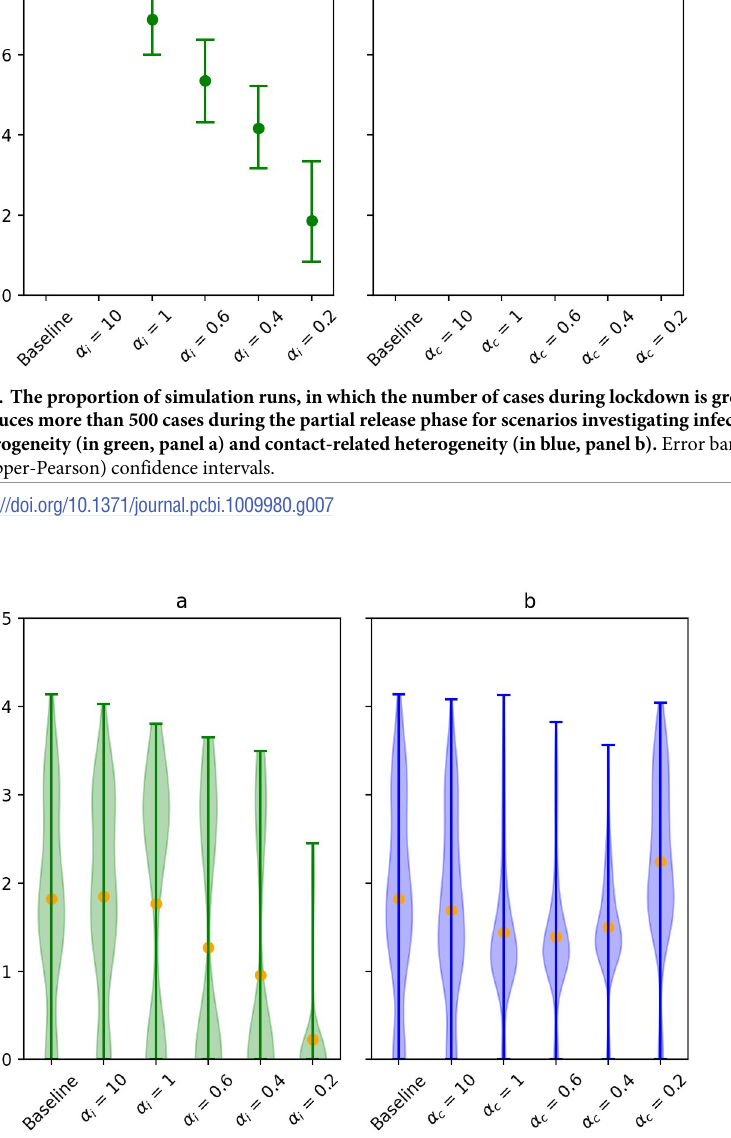
Fig 8. Violin plots for the herd immunity threshold as estimated for the social distancing scenario, when investigating infectiousness-related heterogeneity (in green, panel a) and contact-related heterogeneity (in blue, panel b). The orange dots represent the mean of the simulated